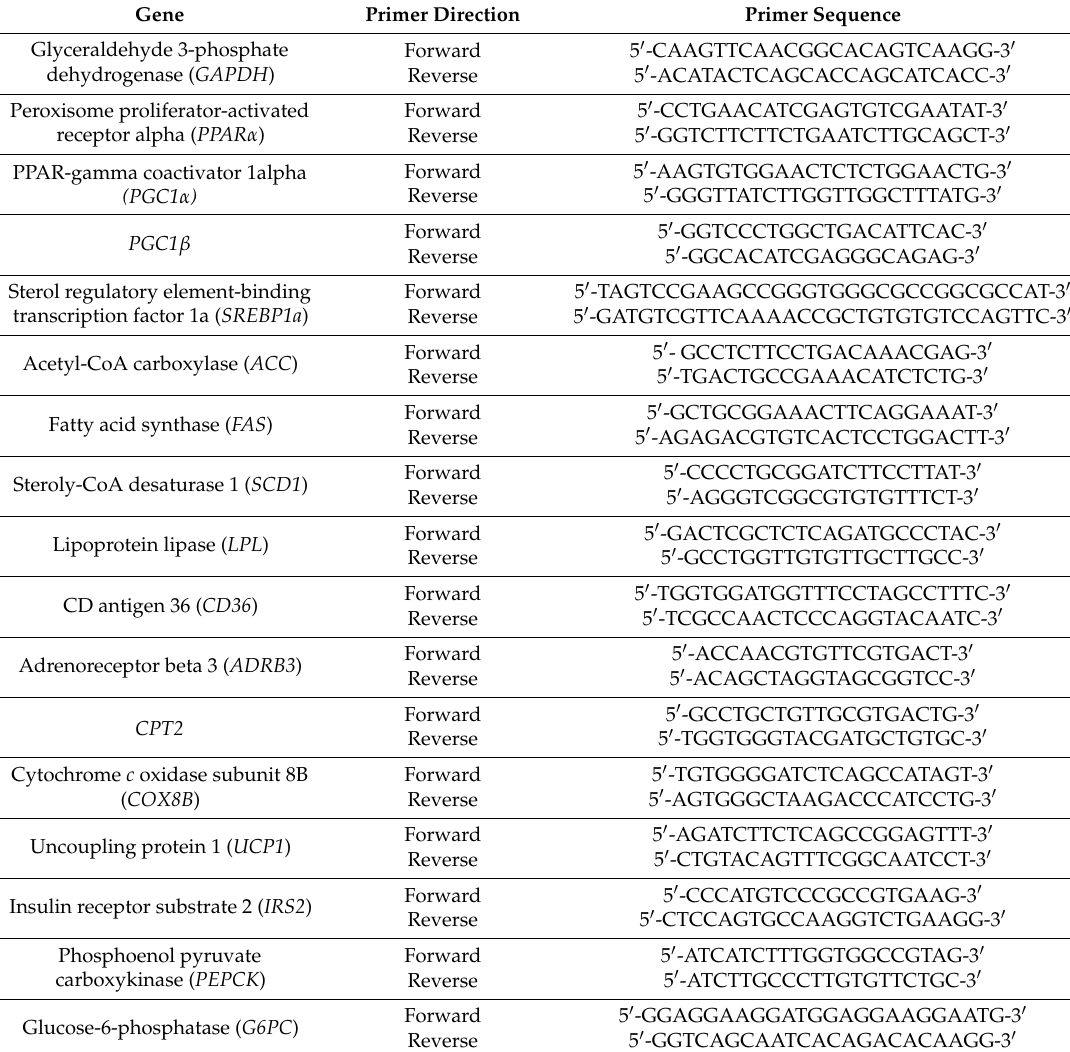
Table 1. Primer sequences used for